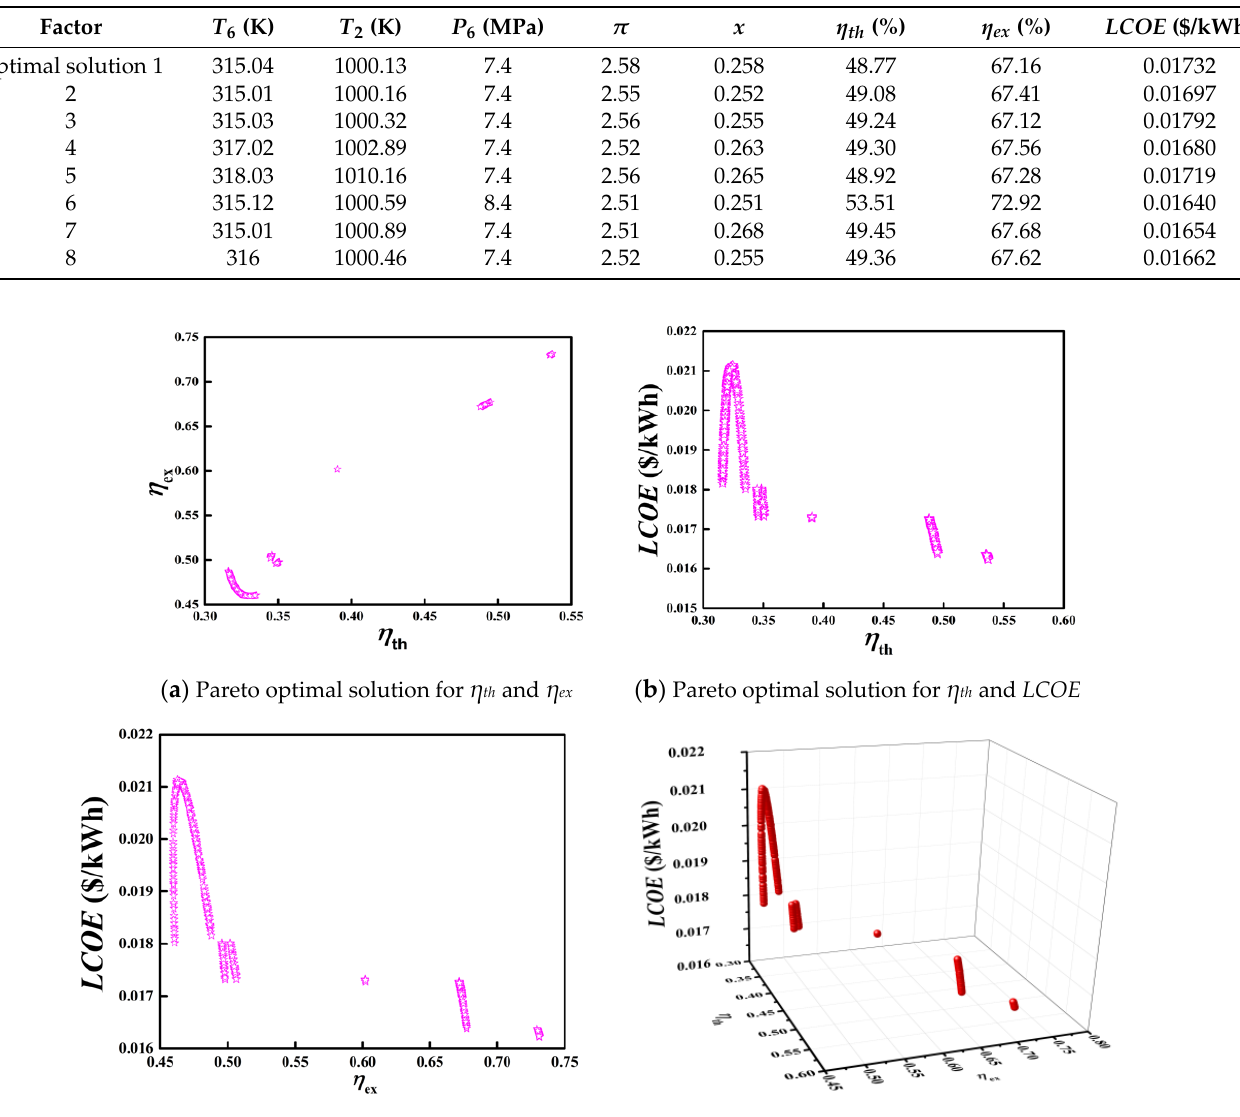
factor is 0.7, and the variation factor is 0.3. Figure 14a–c shows the Pareto optimal boundary,